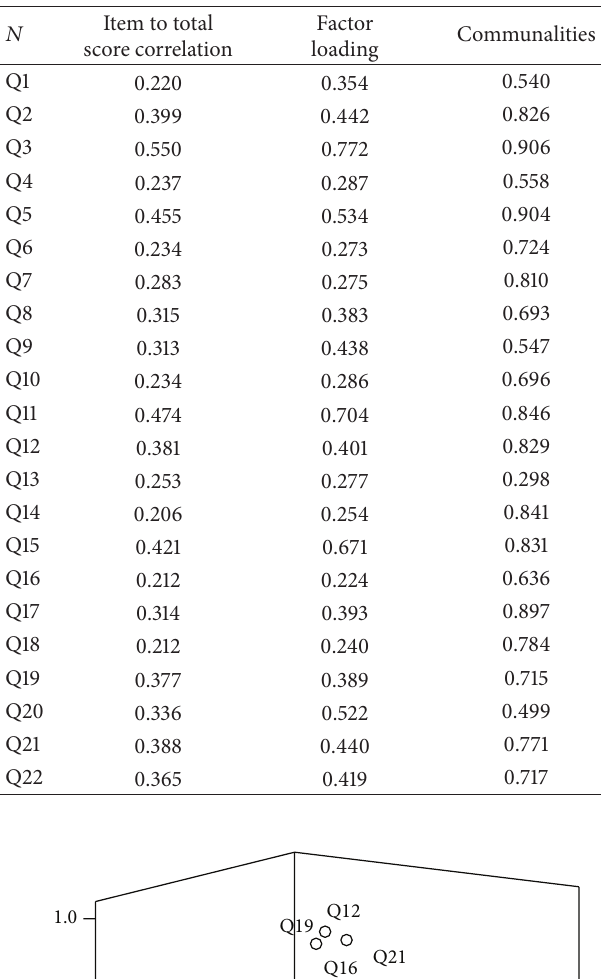
Table 3: Results of factor analysis.